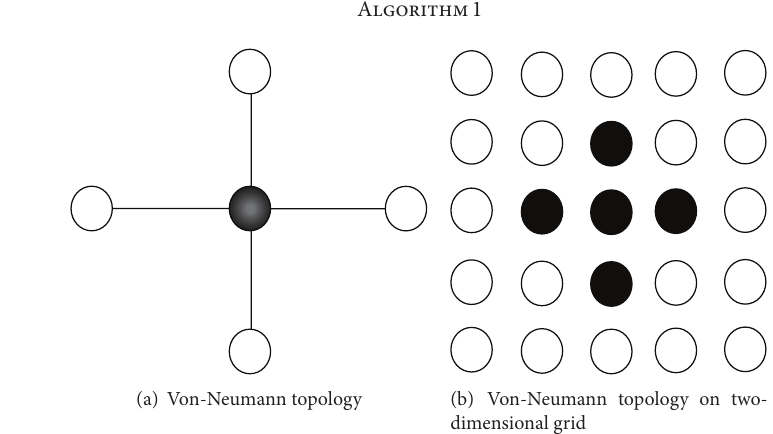
Figure 2: Details of fine-grained population